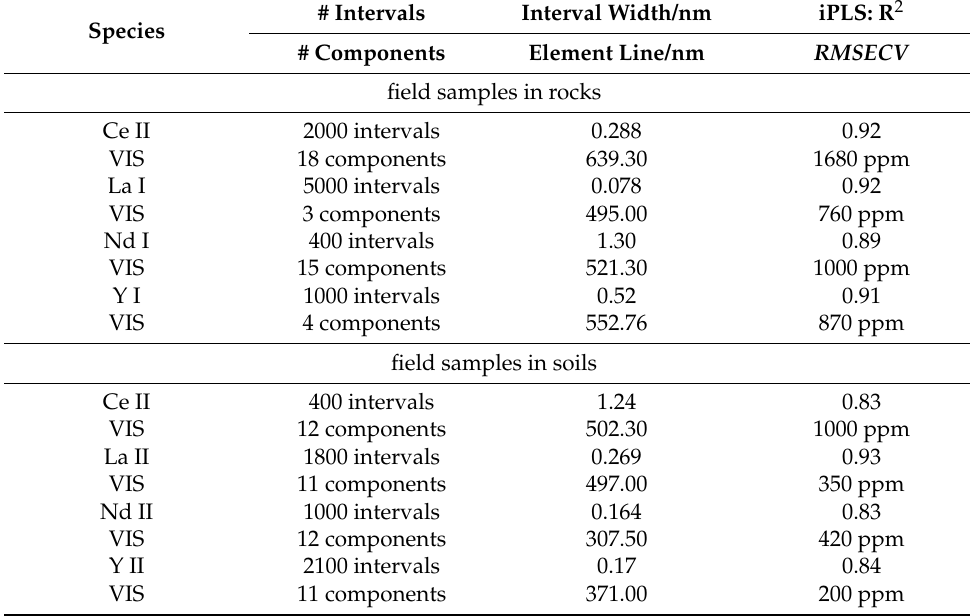
Table 5. Results of i PLS regression of field samples in rocks and soils.